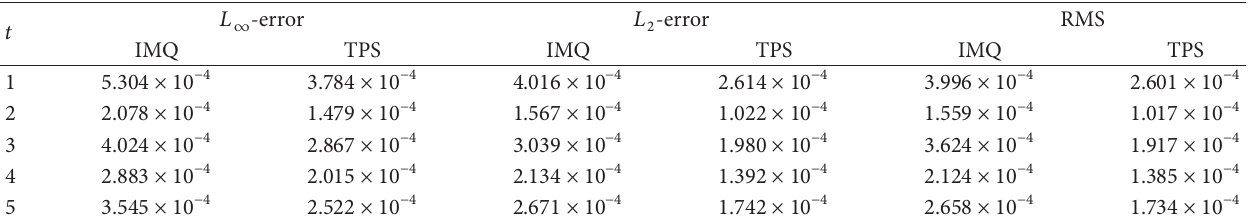
Table 5: Numerical errors using IMQ ( 𝑐 = 0.08 ) and TPS ( 𝑚 = 2 ) represented at different times, where 𝑑𝑥 = 0.01 , 𝑑𝑡 = 0.001 , and 𝜃 = 1/2 . 𝑡